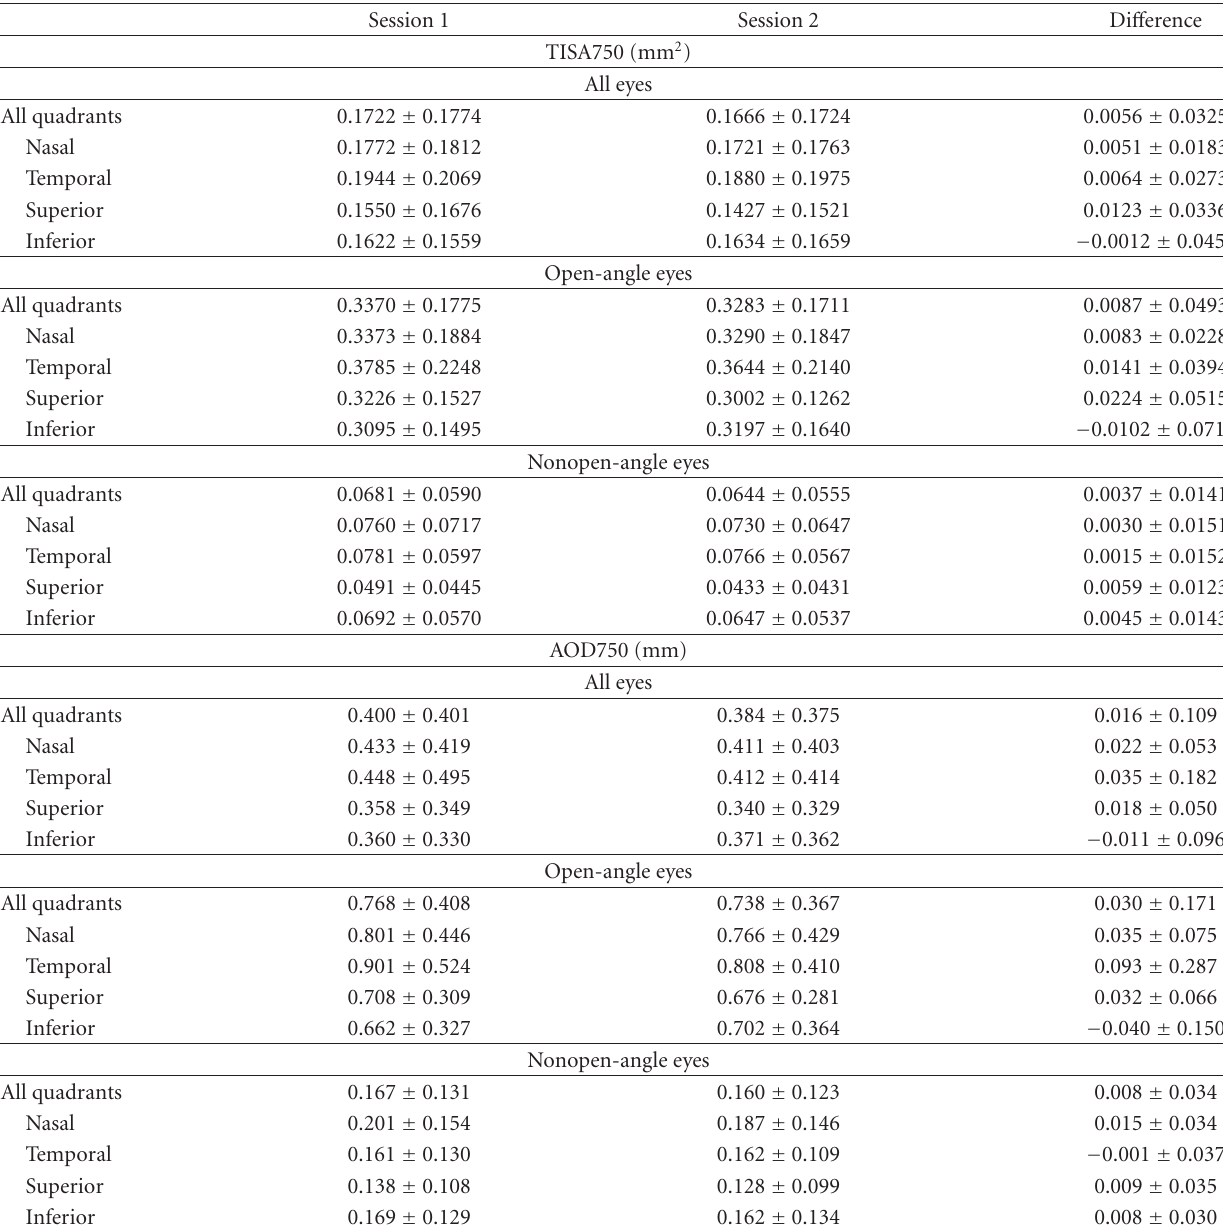
Table 3: Mean ( ± standard deviation) of TISA750 (mm 2 ) and AOD750 (mm) from both sessions by the glaucoma specialist and their di ff